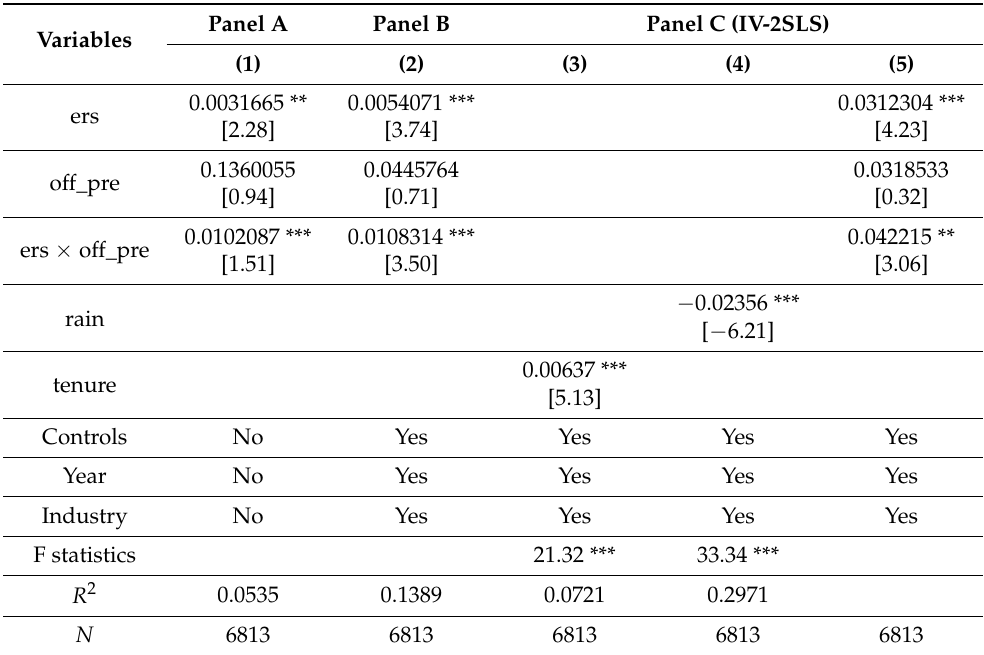
Table 8. Results of moderating effect of city leader’s promotion pressure.